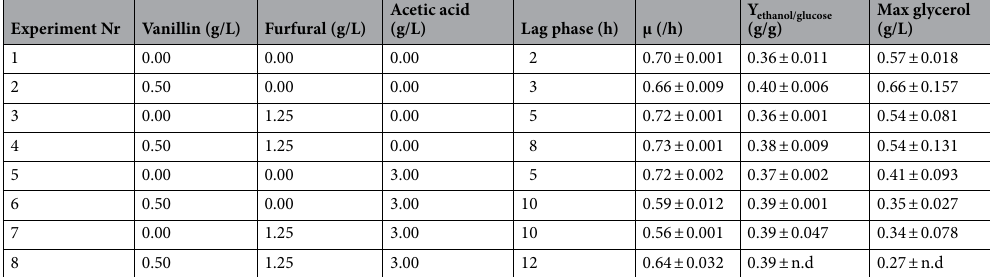
Experiment Nr Vanillin (g/L) Furfural (g/L)